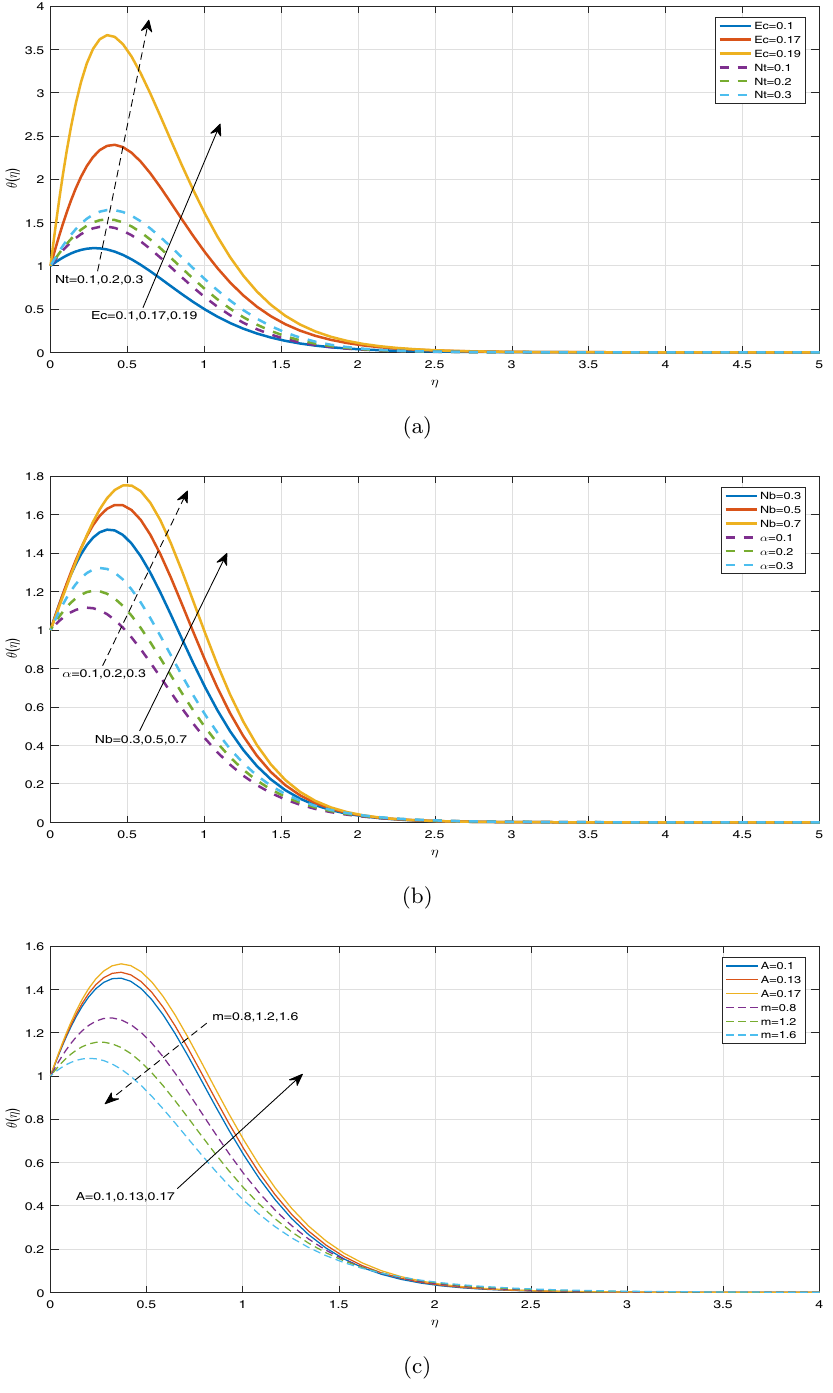
Figure 8. Temperature profiles against ( a ) Ec and Nt , ( b ) Nb and α , ( c ) A and m